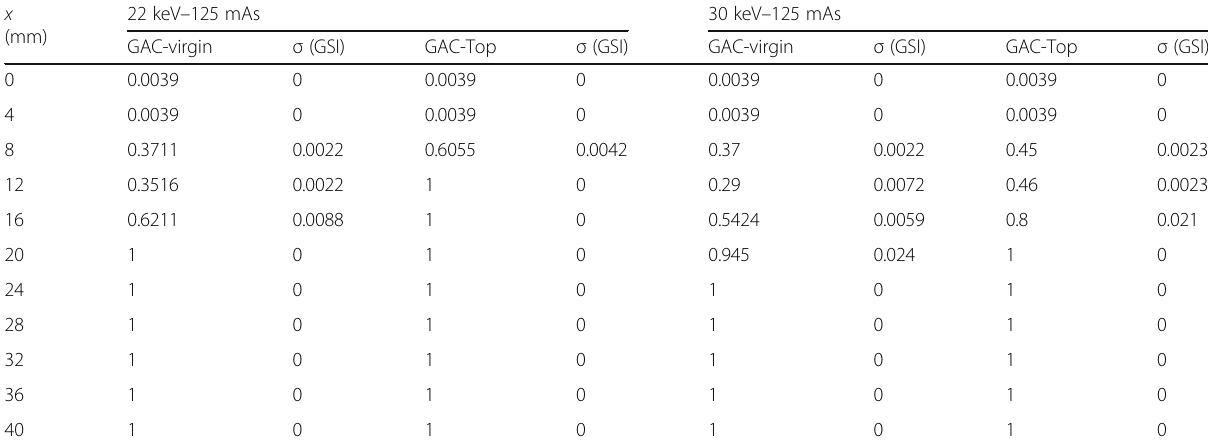
Table 1 Grey-scale intensity (GSI) of the X-ray radiography images for the GAC-Top and GAC-virgin at 22 keV – 125 mAs and 30 keV – 125 mAs